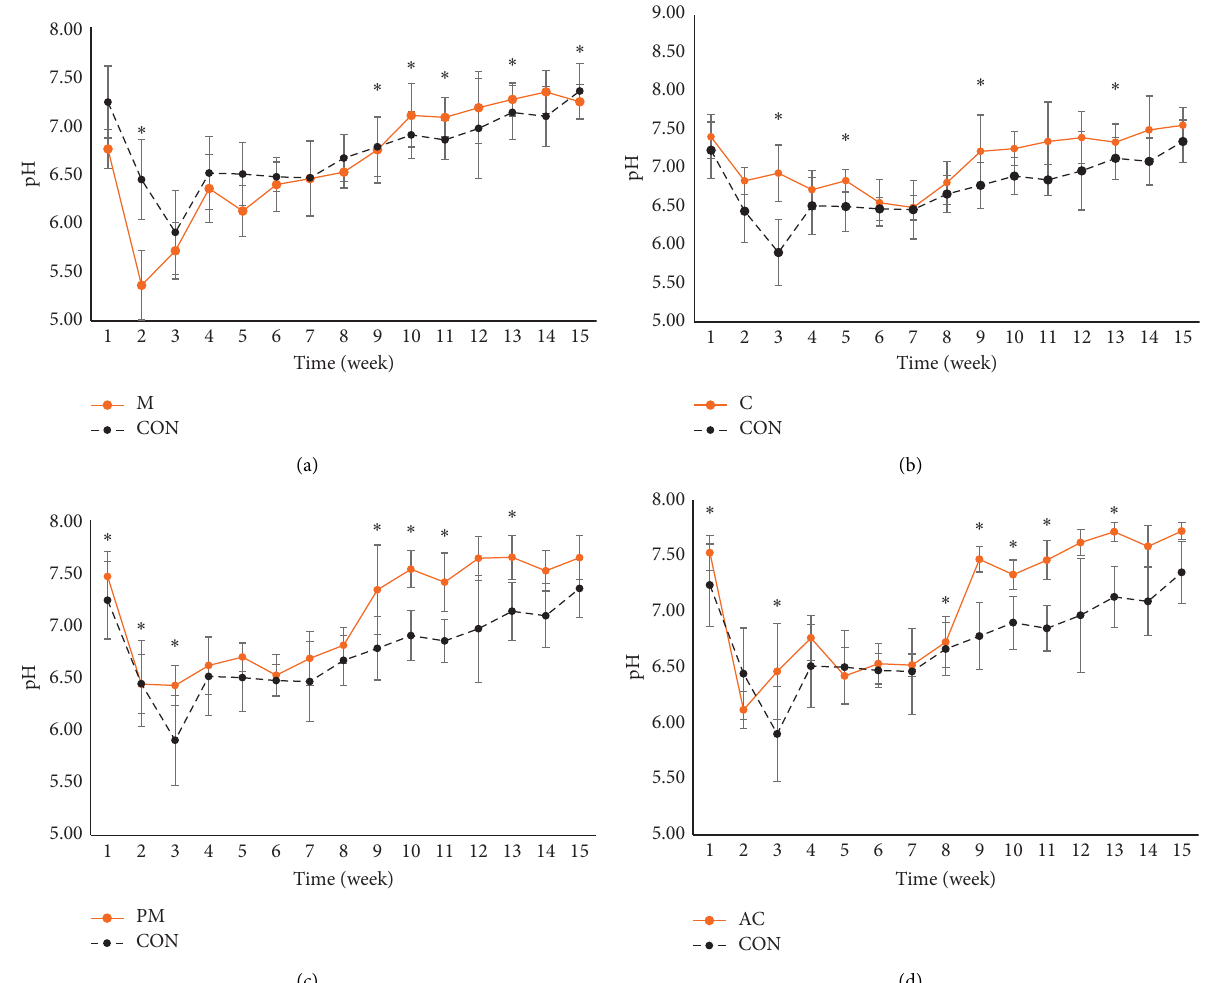
Figure 4: Soil pH values over 15 weeks of treatment; (a) molasses vs. control; (b) compost vs. control; (c) papermill sludge vs. control; and (d) activated carbon vs. control. M: molasses; C: plant compost; PM: papermill sludge; AC: activated carbon; and CON: control. ( ∗ ) indicates that data for the treatment were significantly different ( p < 0.05) from the